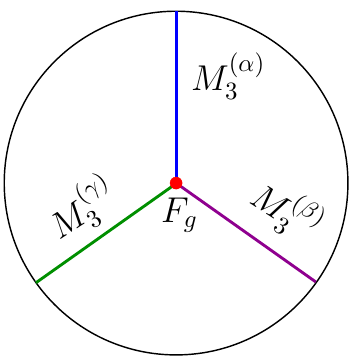
Figure 1 . Cutting a 4-manifold is like cutting a cake: with only three skillful cuts, any 4-manifold can be trisected into three basic pieces.